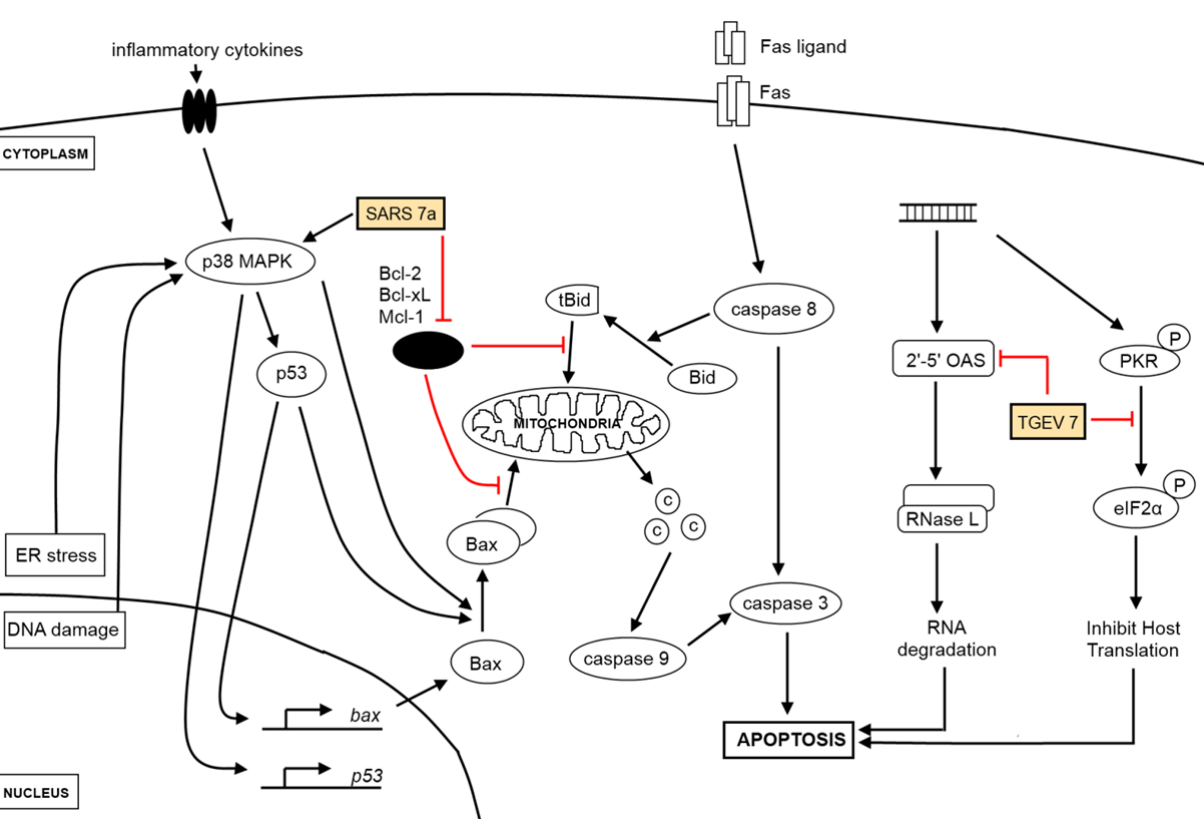
Figure 1. Viral genes and the activation of apoptosis. Extrinsic signals from receptors (e.g., Fas ligand) culminate in the activation of caspase 8, which activates the effector caspase 3 while intrinsic signaling requires the participation of the mitochondria in releasing cytochrome c (shown as circles labeled “C”) to activate caspase 9 for the downstream activation of caspase 3. Key proteins in the intrinsic apoptosis signaling pathway are p53, both pro-apoptotic (e.g., Bax, Bak) and anti-apoptotic proteins (e.g., Bcl-2, Bcl- L) from the Bcl-2 family. Viral genes (see yellow boxes), which act at X multiple points along the different signaling pathways, target both the extrinsic and intrinsic apoptosis signaling pathways and enhances the pro-apoptotic effect brought upon by virus infection. Anti-apoptotic proteins (black oval) listed are key anti-apoptotic members from the Bcl-2 family of proteins. Other pathways triggered by coronavirus infections, such as ER stress and DNA damage response, activate apoptotic signaling pathways as